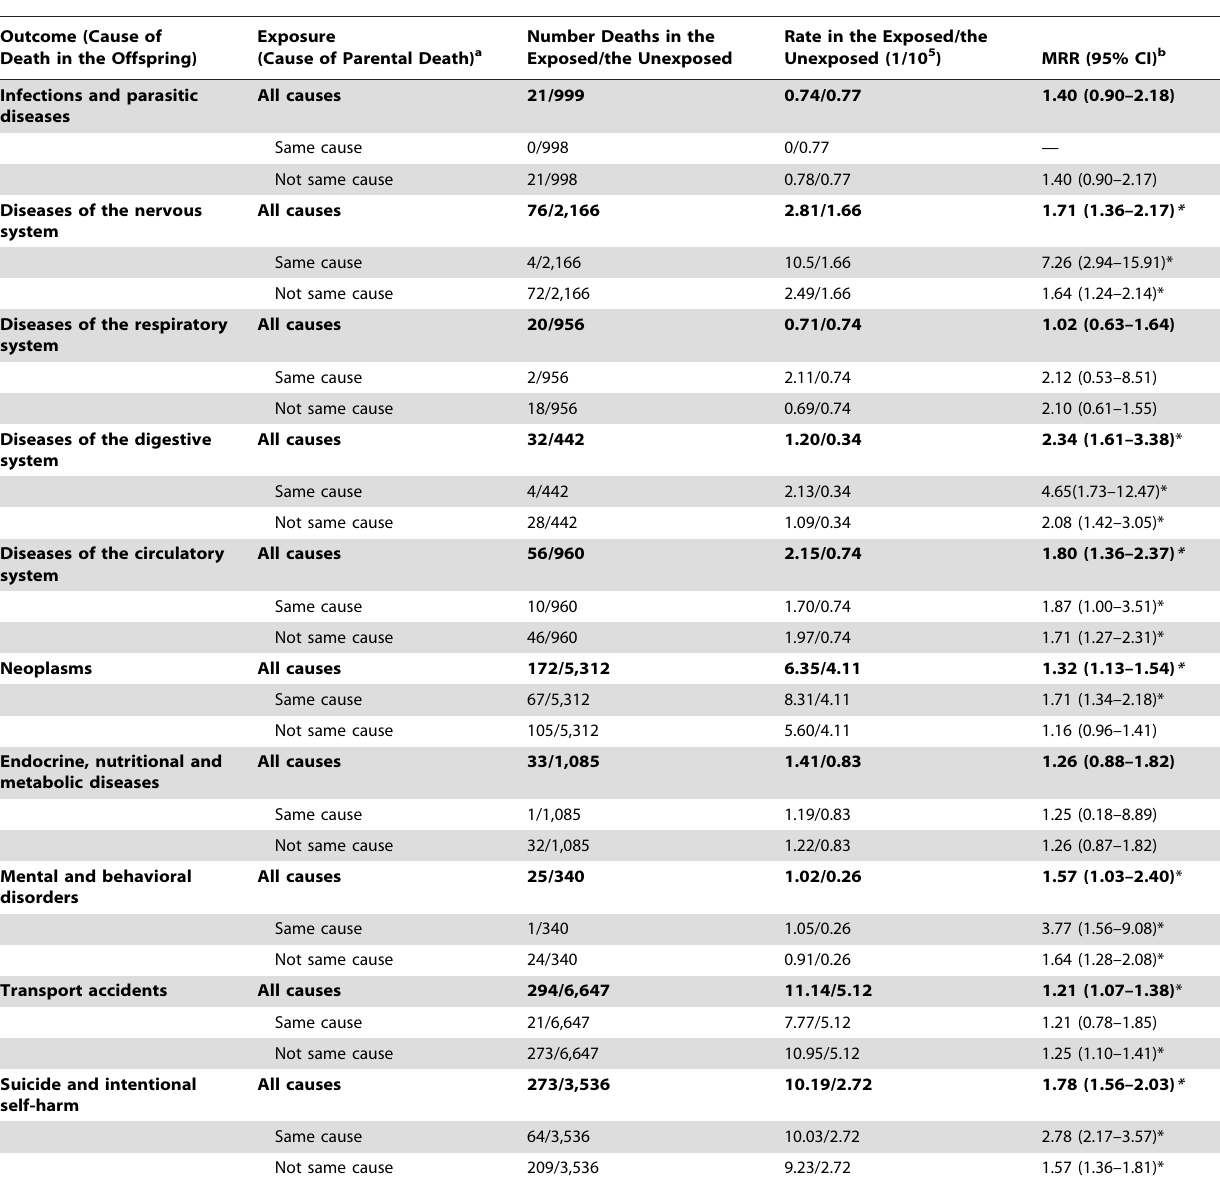
Table 6. Cause-specific mortality rate ratios after parental death in childhood.